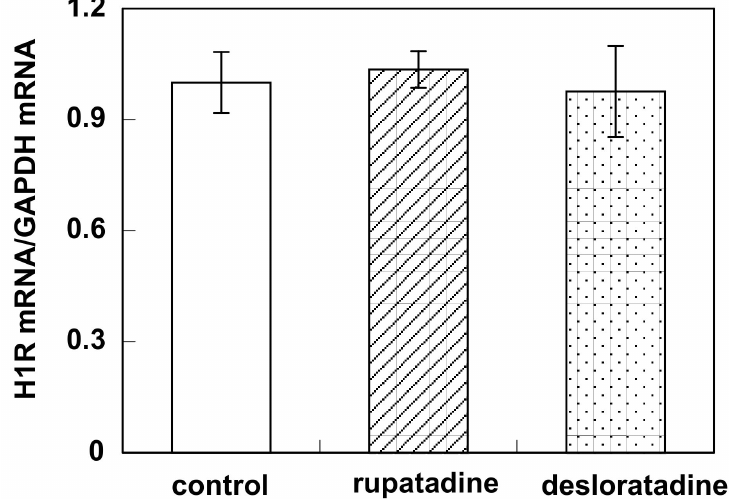
Figure 6. E ff ect of rupatadine and desloratadine on H1R gene expression in HeLa cells. HeLa cells were treated with or without 10 µ M of rupatadine and desloratadine for 4 h. Then the cells were harvested and H1R mRNA was determined by real-time RT-PCR. Data are expressed as means ± SEM ( n =